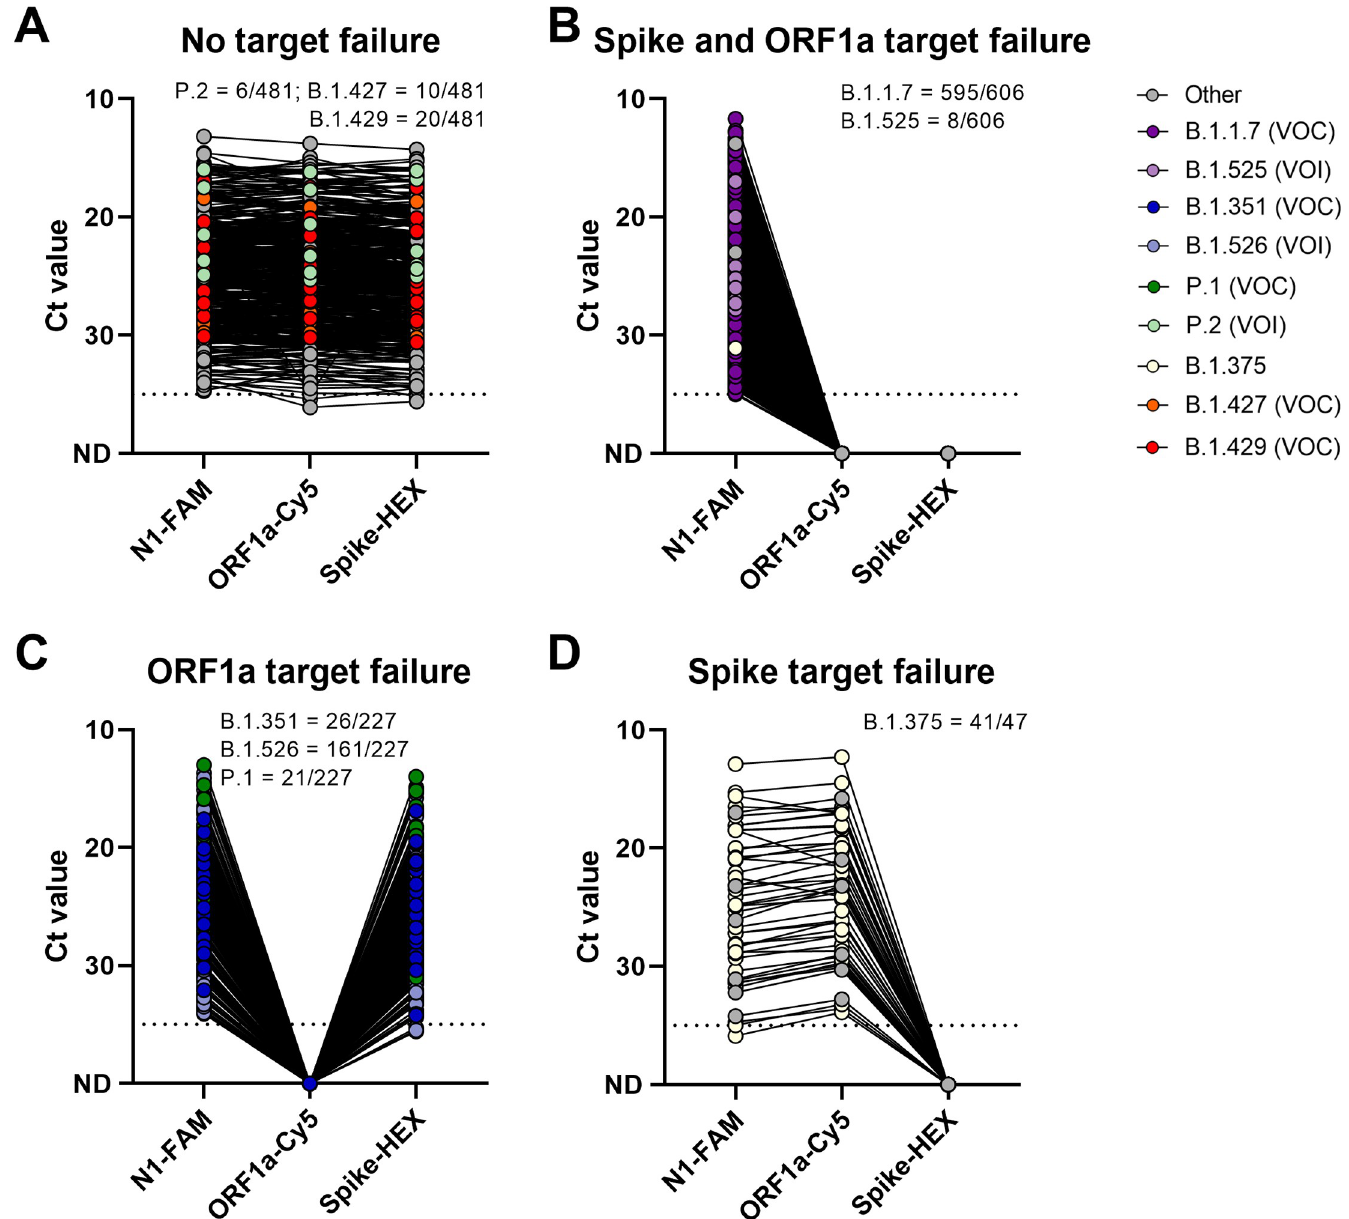
Fig 2. ORF1a and spike target failure used to differentiate between SARS-CoV-2 VOC B.1.1.7, B.1.351, P.1, and other lineages currently not of concern. ( A ) Lineages (including B.1.427 and B.1.429) without target failure are detected by all 3 targets of the multiplex RT-qPCR assay. ( B ) Double target failure indicates the presence of the ORF1a Δ 3675–3677 and spike Δ 69–70 deletions and can be used to identify potential B.1.1.7 variants. ( C ) ORF1a target failure indicates the presence of the ORF1a Δ 3675–3677 deletion, present in B.1.351 and P.1 VOC. ( D ) Spike target failure indicates presence of the spike Δ 69–70 deletion, which is present in various lineages, including B.1.375. Shown are the Ct values for the N1, ORF1a, and spike primer–probe sets, with lines connecting Ct values obtained with the 3 sets for the same specimen. The dotted line indicates the limit of detection. Data used to make this figure can be found in S2 Data . Ct, cycle threshold; RT-qPCR,